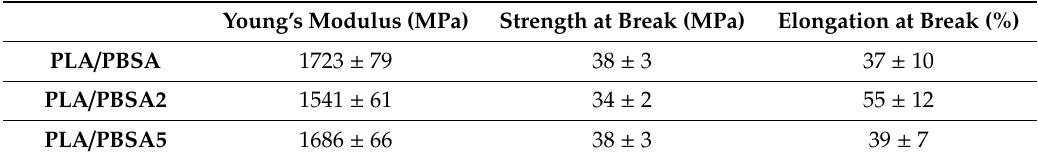
Table 6. Mechanical parameters for the multilayer film PLA / PBSA